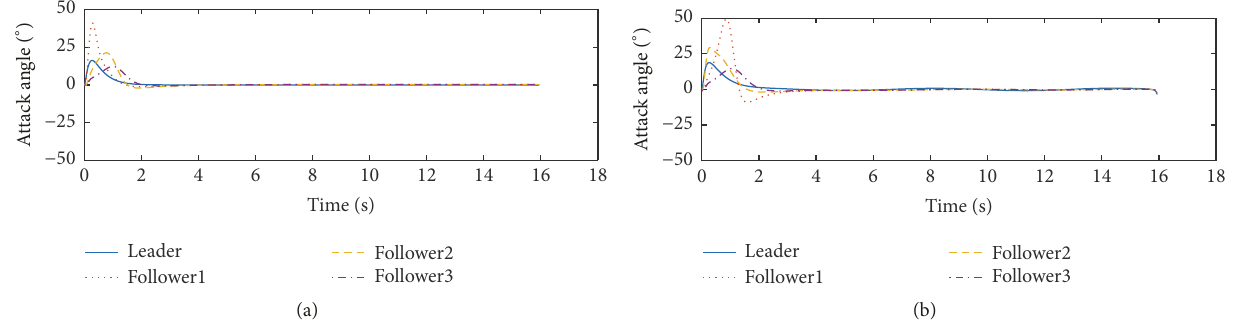
Figure 12: Comparison of the interceptor’s attack angle curves in the design methods with and without state coupling: (a) attack angle curve in the design method with state coupling; (b) attack angle curve in the design method without state coupling.